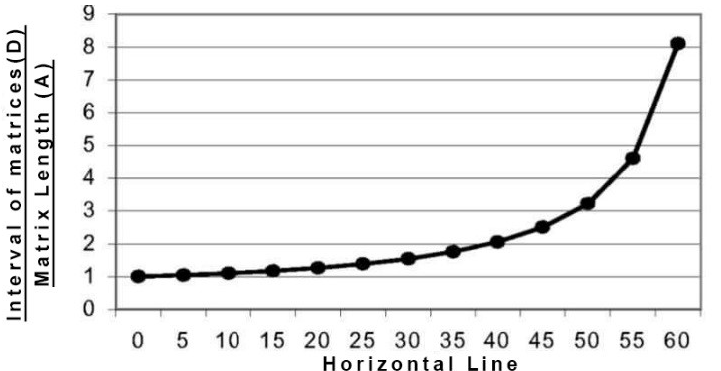
Figure 12. Relation between the fixed arrays and the citylatitude (”Top 50 Solar”, n.d.)